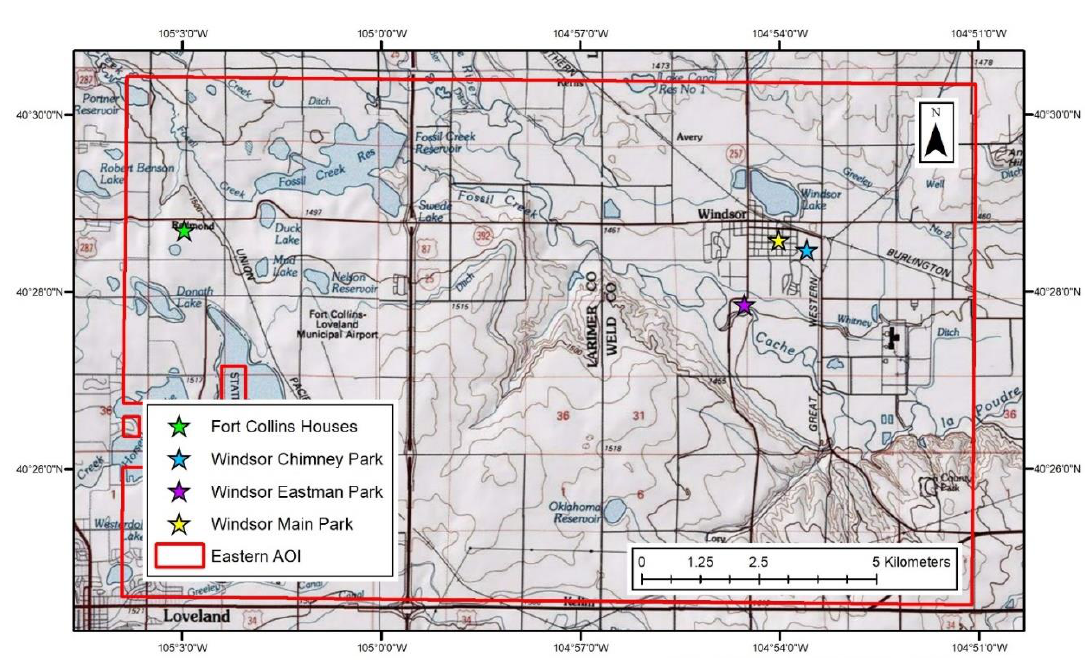
Figure 2. Map of the eastern AOI field sites.